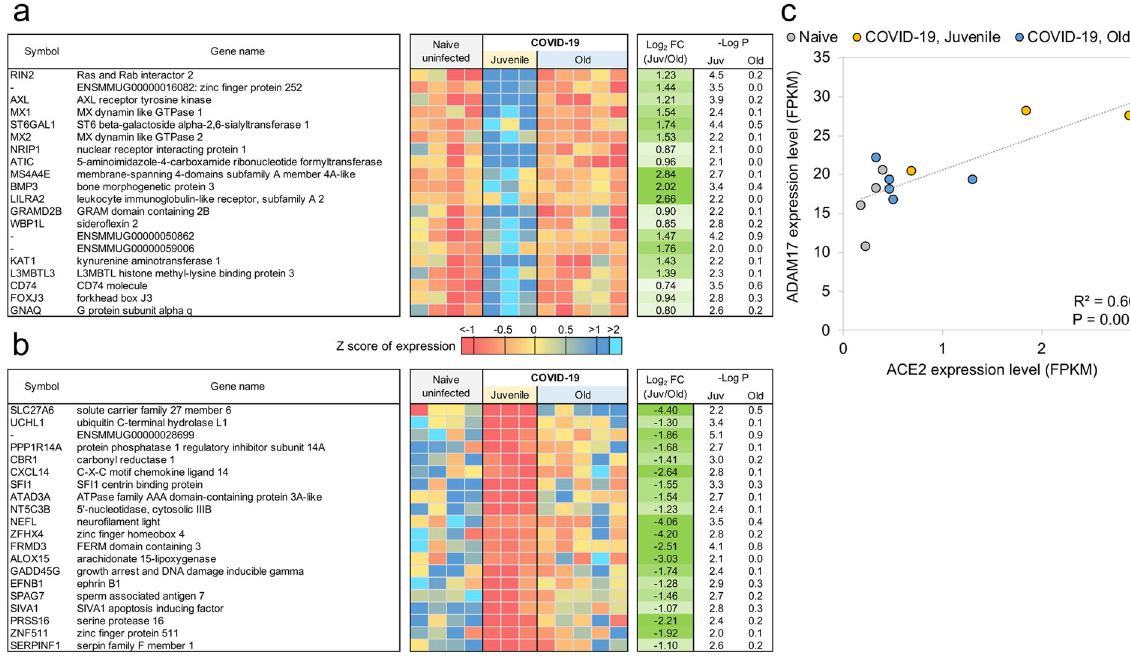
Fig. 4 Genes related to Type I interferon signaling are upregulated in juvenile macaques compared to old macaques during COVID-19-infection. The top 20 most signi fi cantly a upregulated genes and b downregulated genes in SARS-CoV-2 infected juvenile macaque lungs but not in old macaques. Expression values are visualized by Z scores of normalized expression data (FPKM) per sample, and Log 2 Fold Change and -Log P values are from the DESeq2 output. Genes are sorted by P value. c The relative gene expression of ACE2 and ADAM17 among naive, juvenile and old SARS-CoV-2-infected